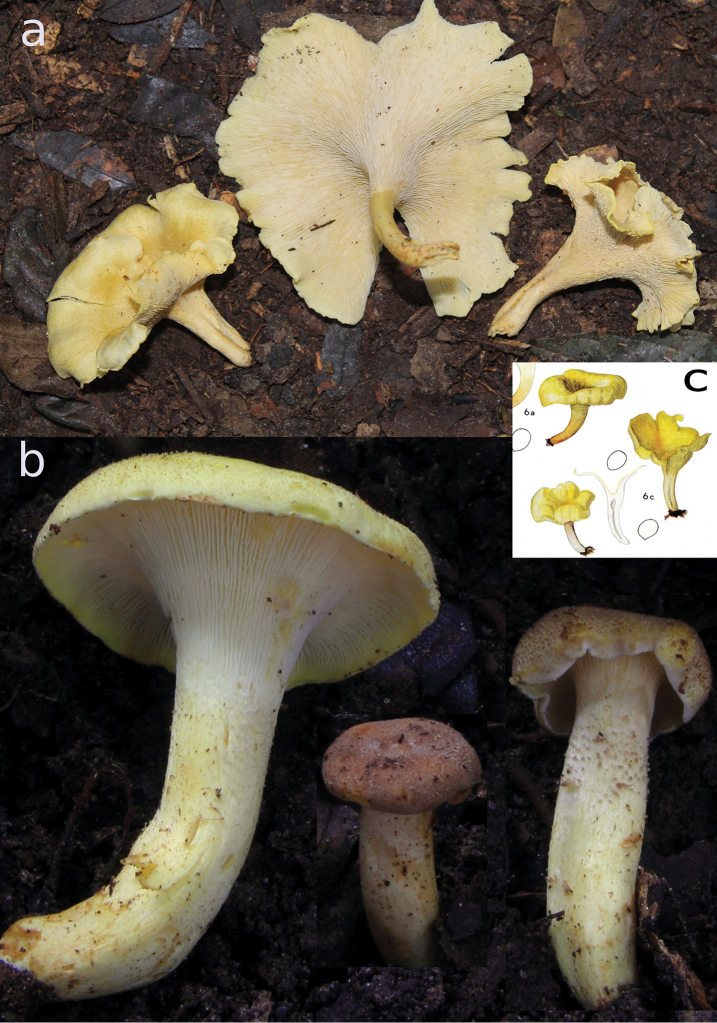
Cantharellusluteopunctatus. a Field habit of the epitype (TH 10285) b details of younger basidiomata from specimen TH 9921, showing the gradual color change of the pileus going from pinkish brown in youngest stages to pale yellow in older stages because of the less dense squamulae; similar squamulae are present on the stipe surface. Composition based on photos by Terry Henkel and Todd Elliott c original watercolor of the holotype by Mme. Goossens-Fontana from Heinemann (1959), reproduced with the permission of Botanic Garden Meise, Belgium.